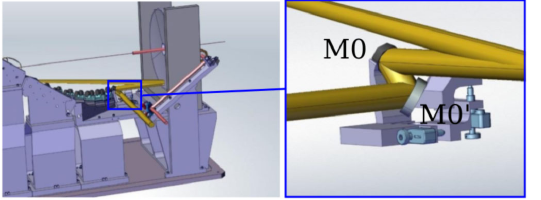
FIG. 12. (left) — 3D view of the integration of the injection mirrors system allowing an injection in the bottom of the M1 parabola. (right) — 3D view of the injection mirrors system with the M0 and M0 ’ mirrors and adjusting high resolution screws.